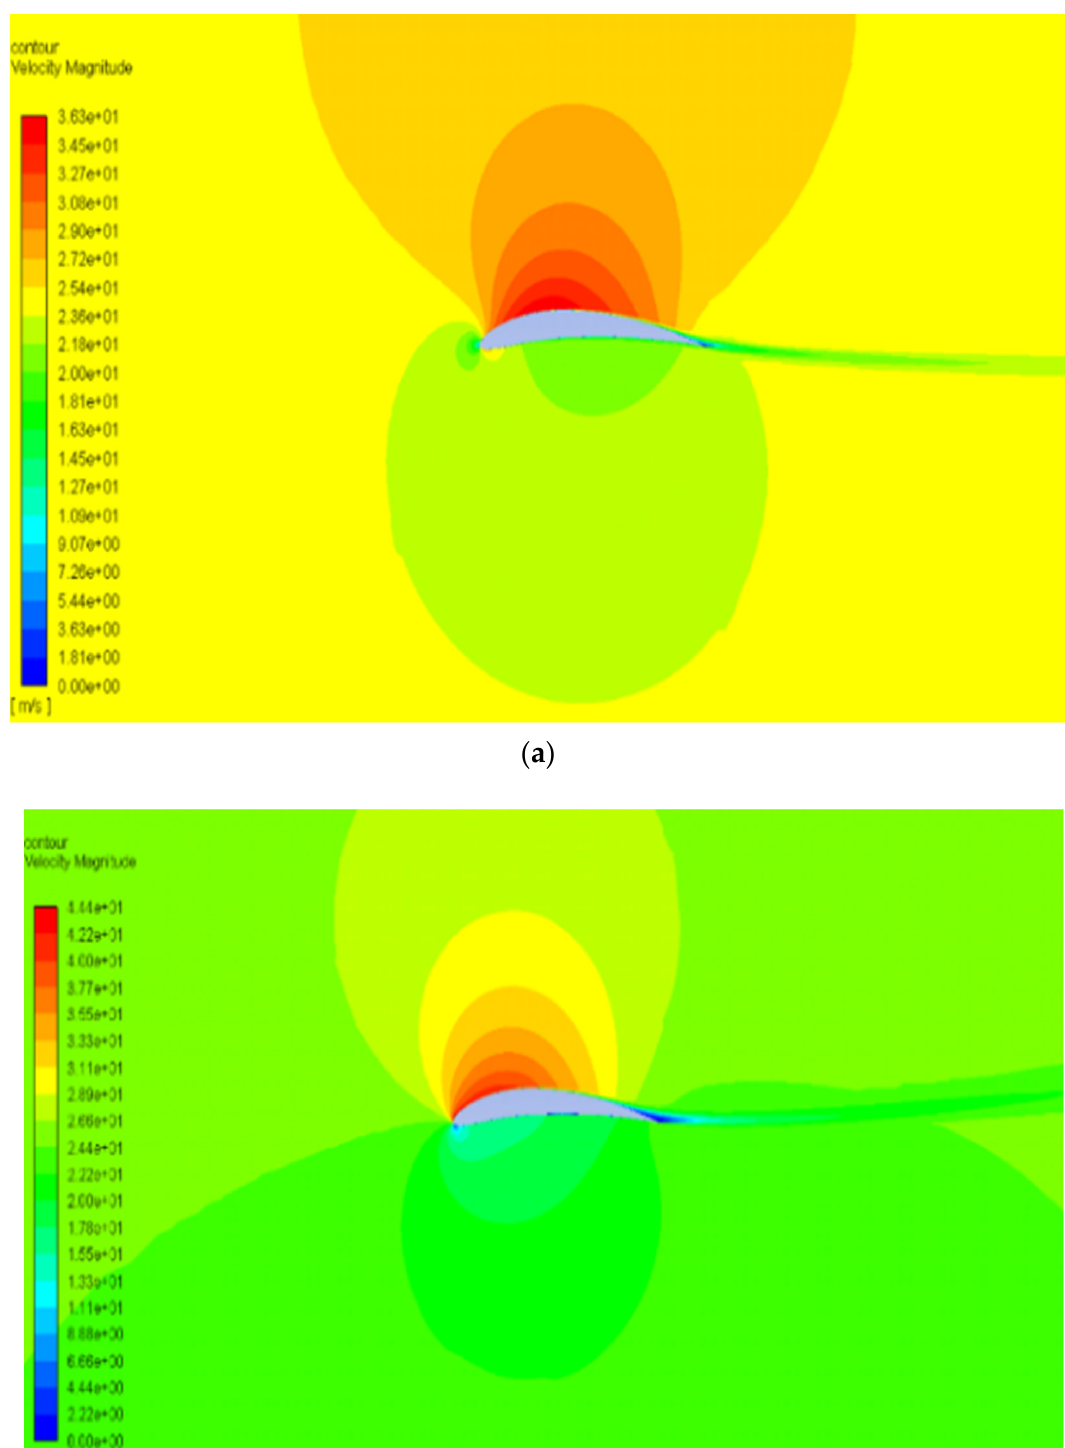
Figure 12. Pressure contour of NACA8410 with AoA ( a ) 1° and ( b ) 8°.